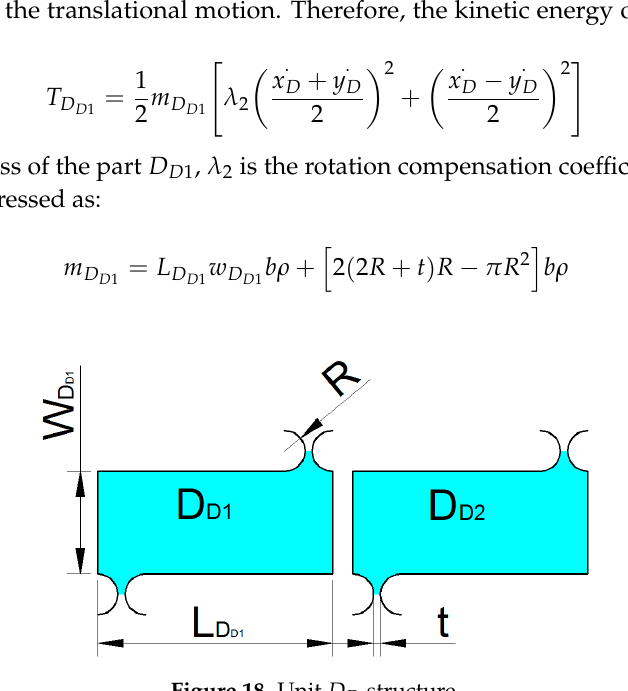
Figure 18. Unit 𝐷 (cid:3005) structure. Figure 18. Unit D D